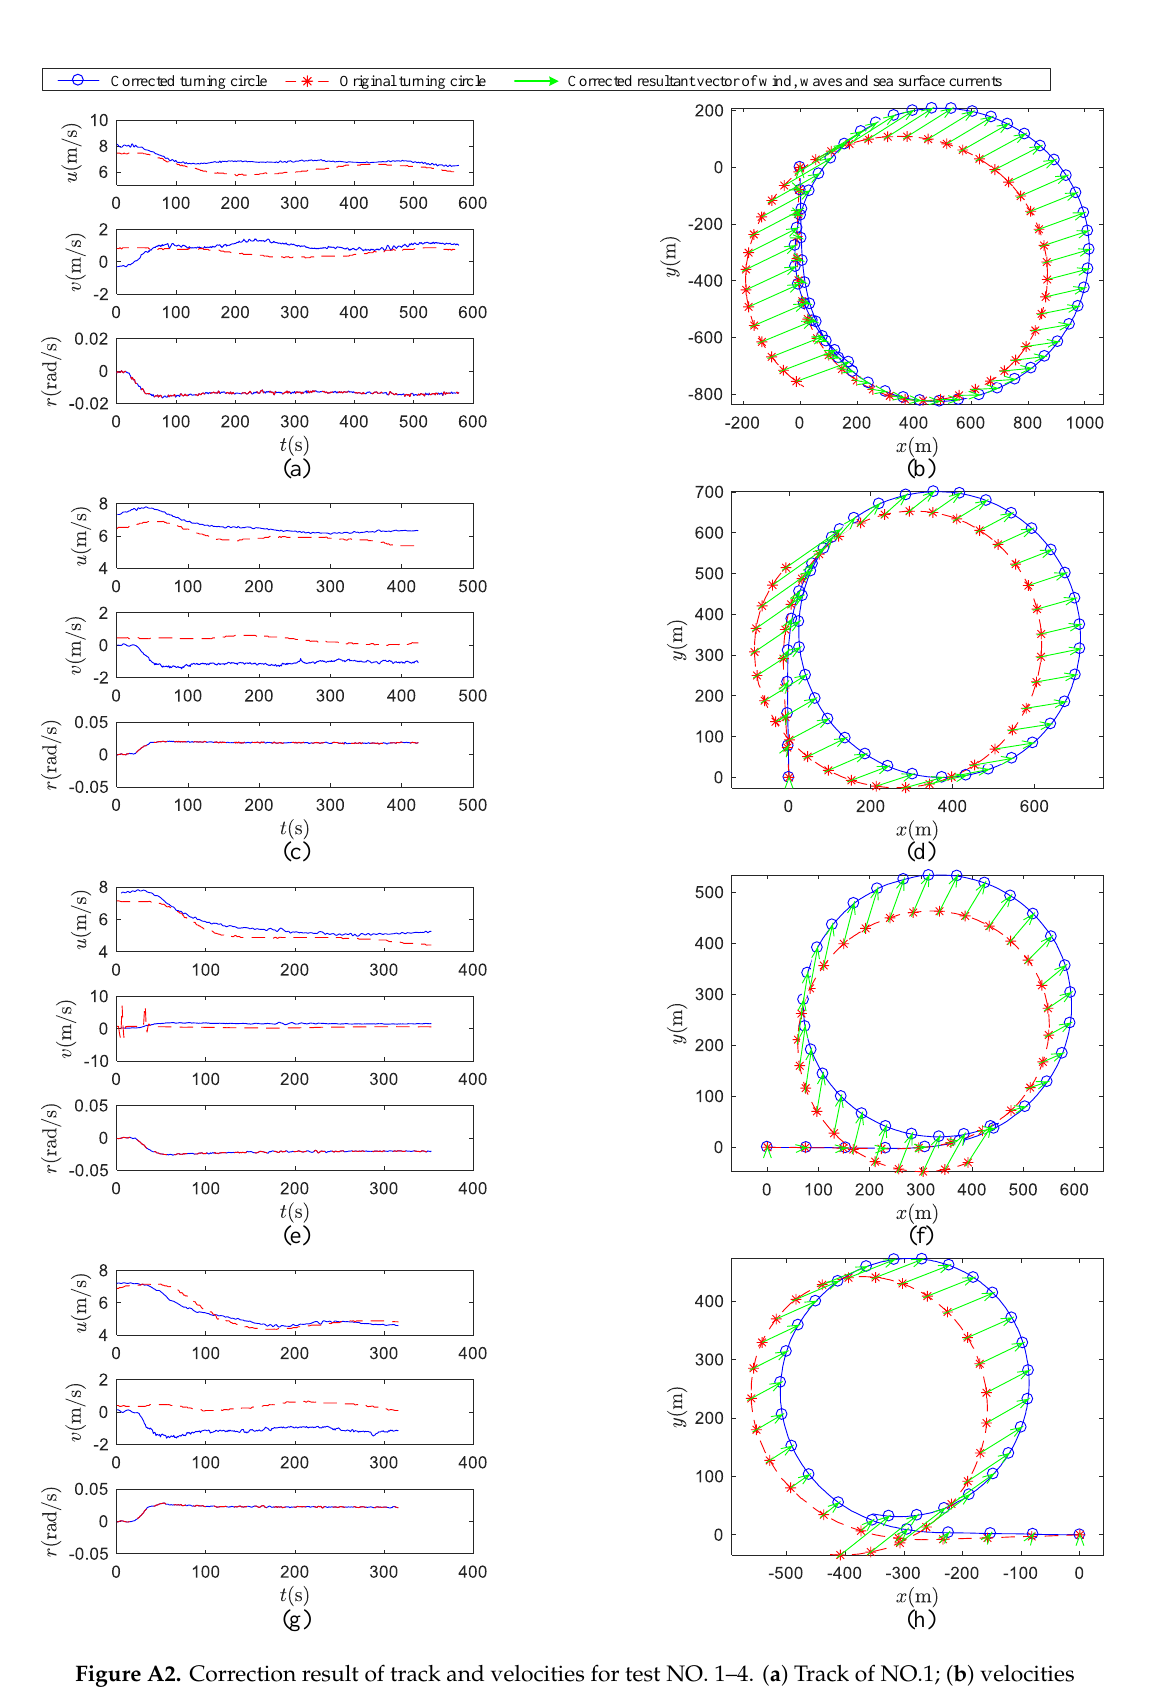
Figure A2. Correction result of track and velocities for test NO. 1–4. ( a ) Track of NO.1; ( b ) velocities of NO.1; ( c ) track of NO.2; ( d ) velocities of NO.2; ( e ) track of NO.3; ( f ) velocities of NO.3; ( g ) track of NO.4; ( h ) velocities of NO.4.